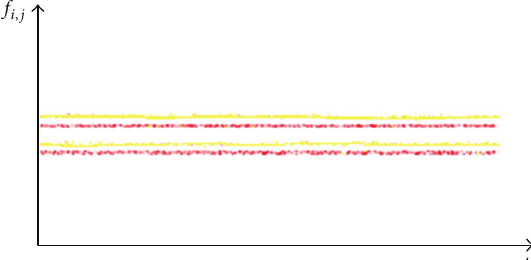
Figure 9: Schematic diagram of extraction of effective instanta- neous frequency